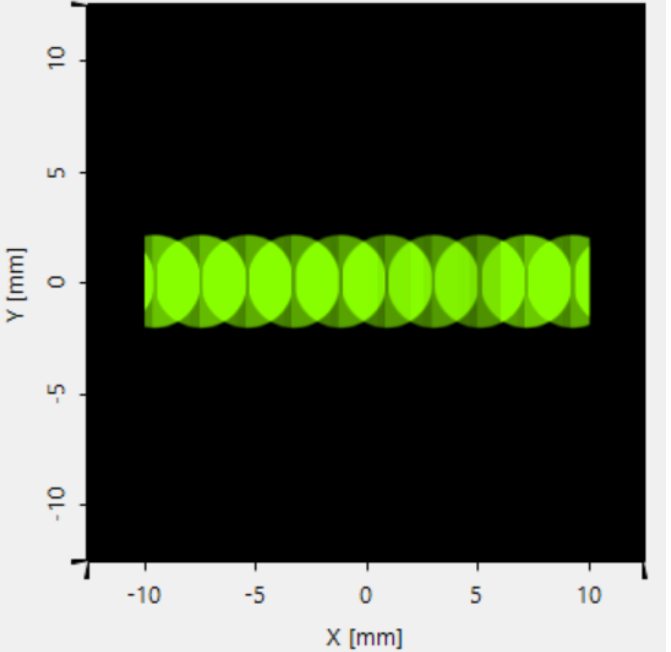
Figure 9. Uniformity analysis of duplicated exit pupils by calculating the electromagnetic fields at the detector. The overlapped regions of pupils, where the light interferes with one another, are treated with coherent summation.